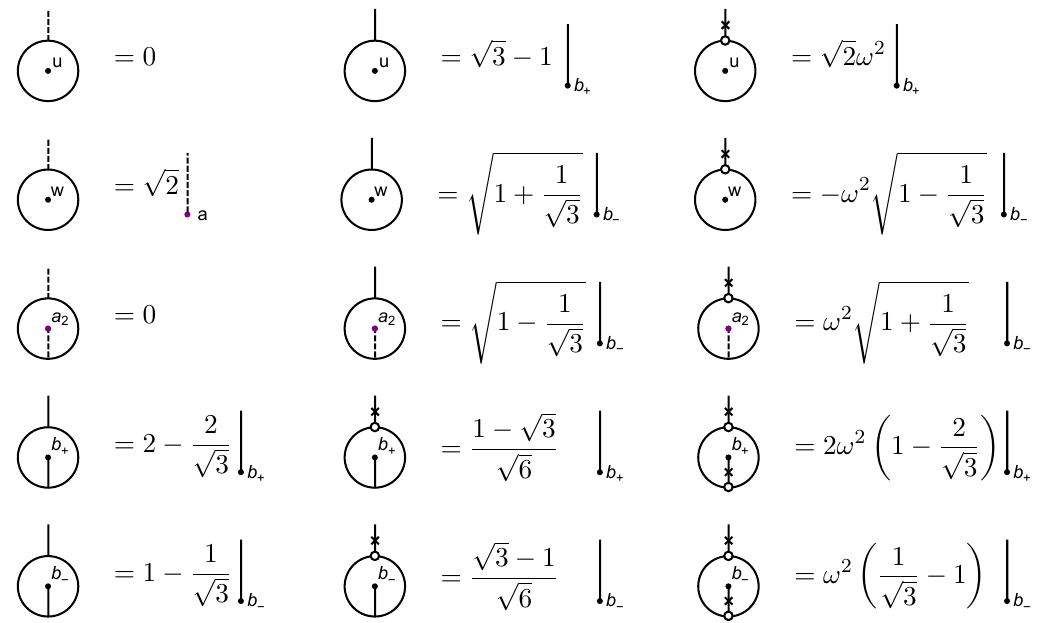
E 6 TQFT. We only include the inde- 2